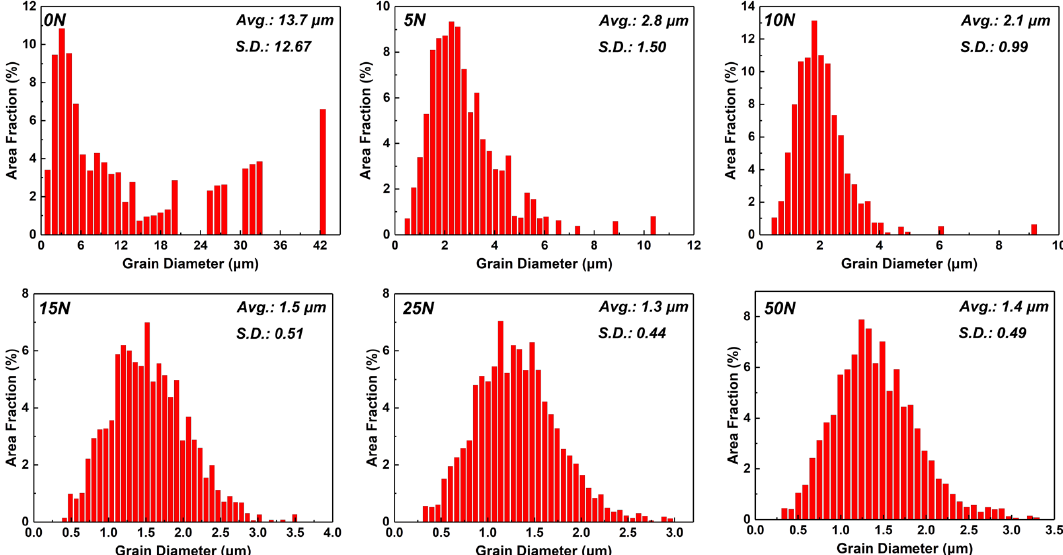
Figure 11. Grain size distribution histograms in the inner wall region of extruded samples with different N based on electron backscatter diffraction (EBSD) statistics.